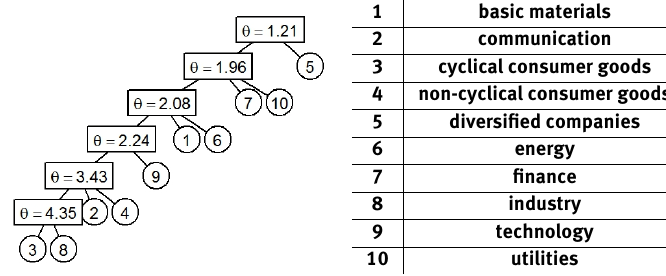
7 The function estimate.copula() with method=ML was